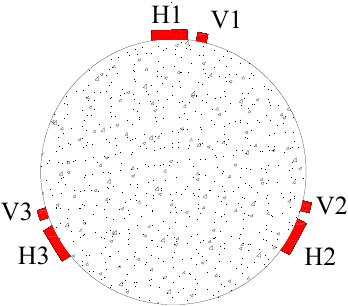
Figure 1. The arrangement of the strain gauges.